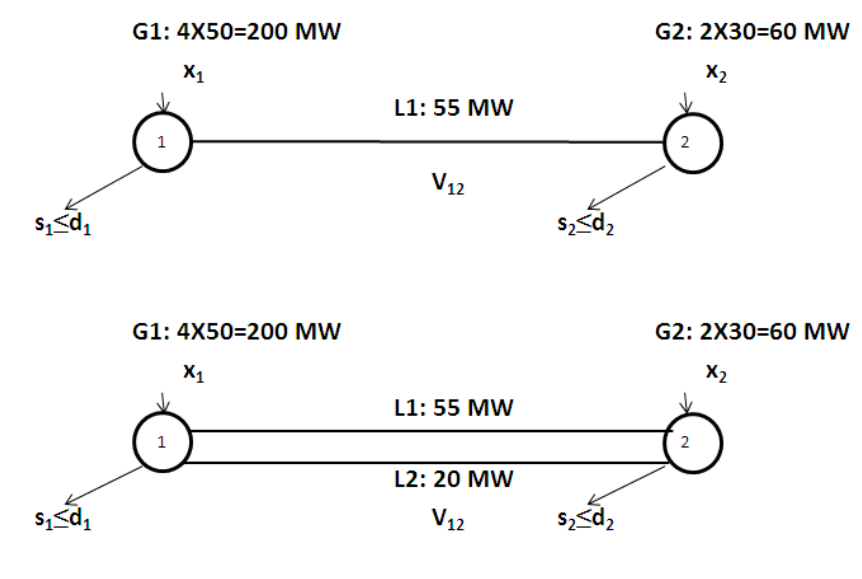
Figure 2. Simple transmission model and potential